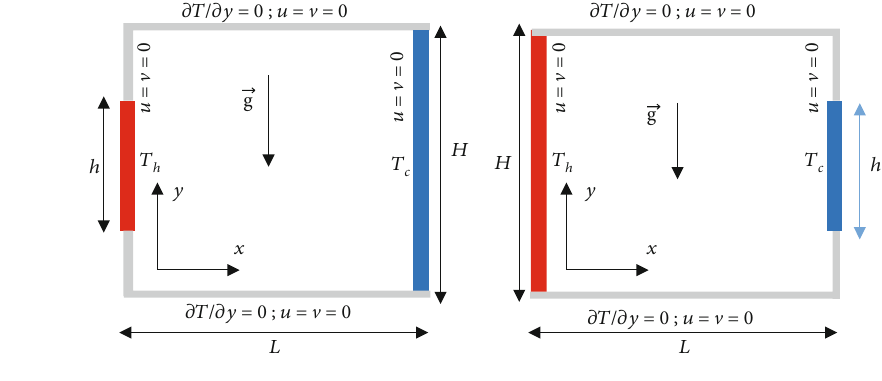
Figure 1: Studied